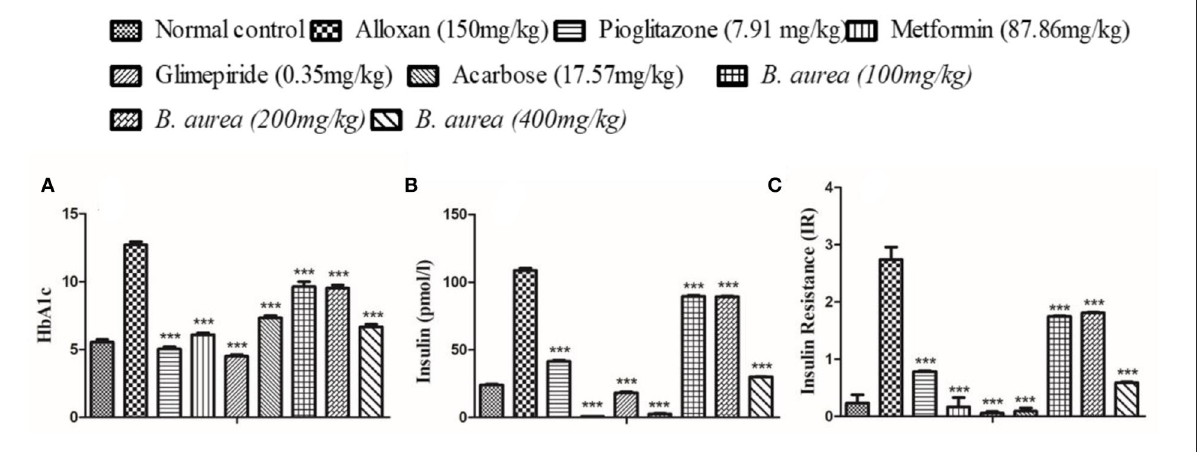
FIGURE8 Effect of B. aurea on HbA1c, insulin, and insulin resistance in diabetic animals. (A) HbA1c, (B) insulin level, and (C) insulin resistance. *** p < 0.001, ** p < 0.01, * p < 0.05 significant